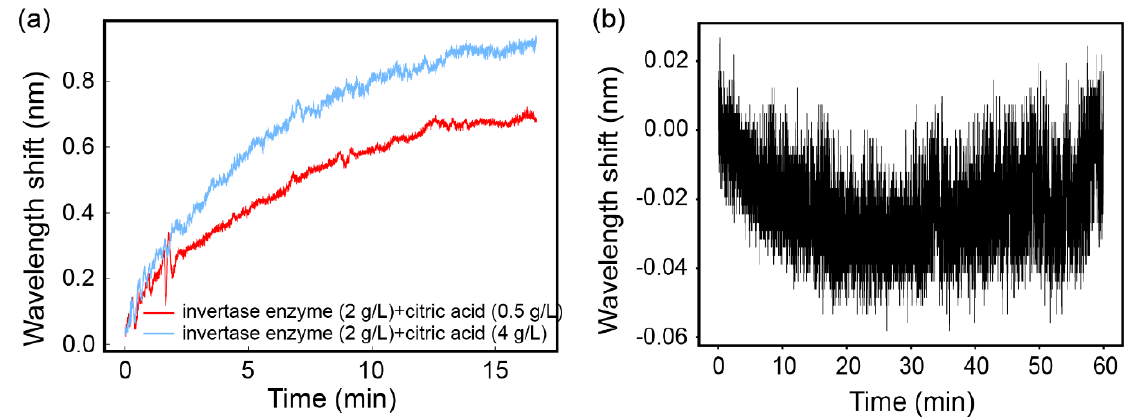
Figure 8. ( a ) The hydrolysis with invertase enzyme and citrate. ( b ) The blank measurement for deionized water in 1 h.